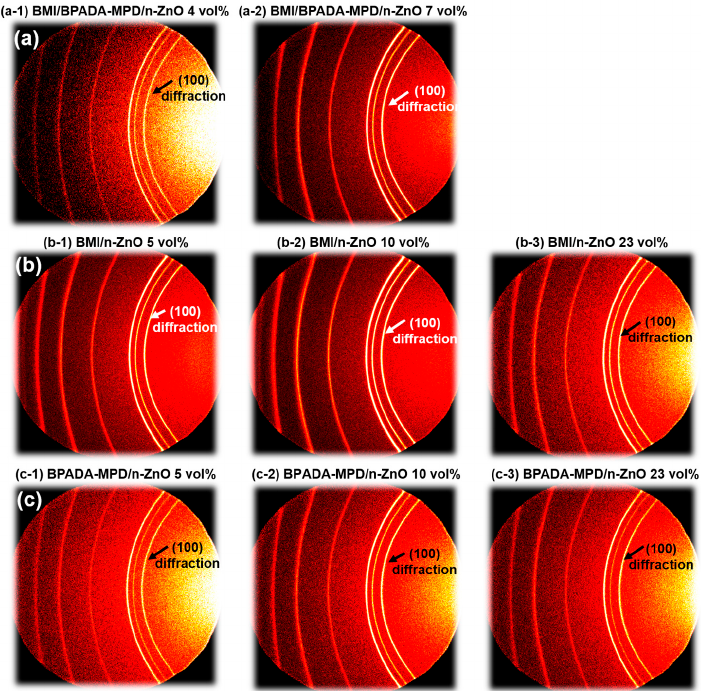
Figure 8. WAXD patterns of n-ZnO particles incorporated into ( a ) BMI/BPADA-MPD/n-ZnO blend (4 and 7 vol %); ( b ) BMI/n-ZnO (5, 10 and 23 vol %); and ( c ) BPADA-MPD/n-ZnO (5, 10 and 23 vol %) composite films.